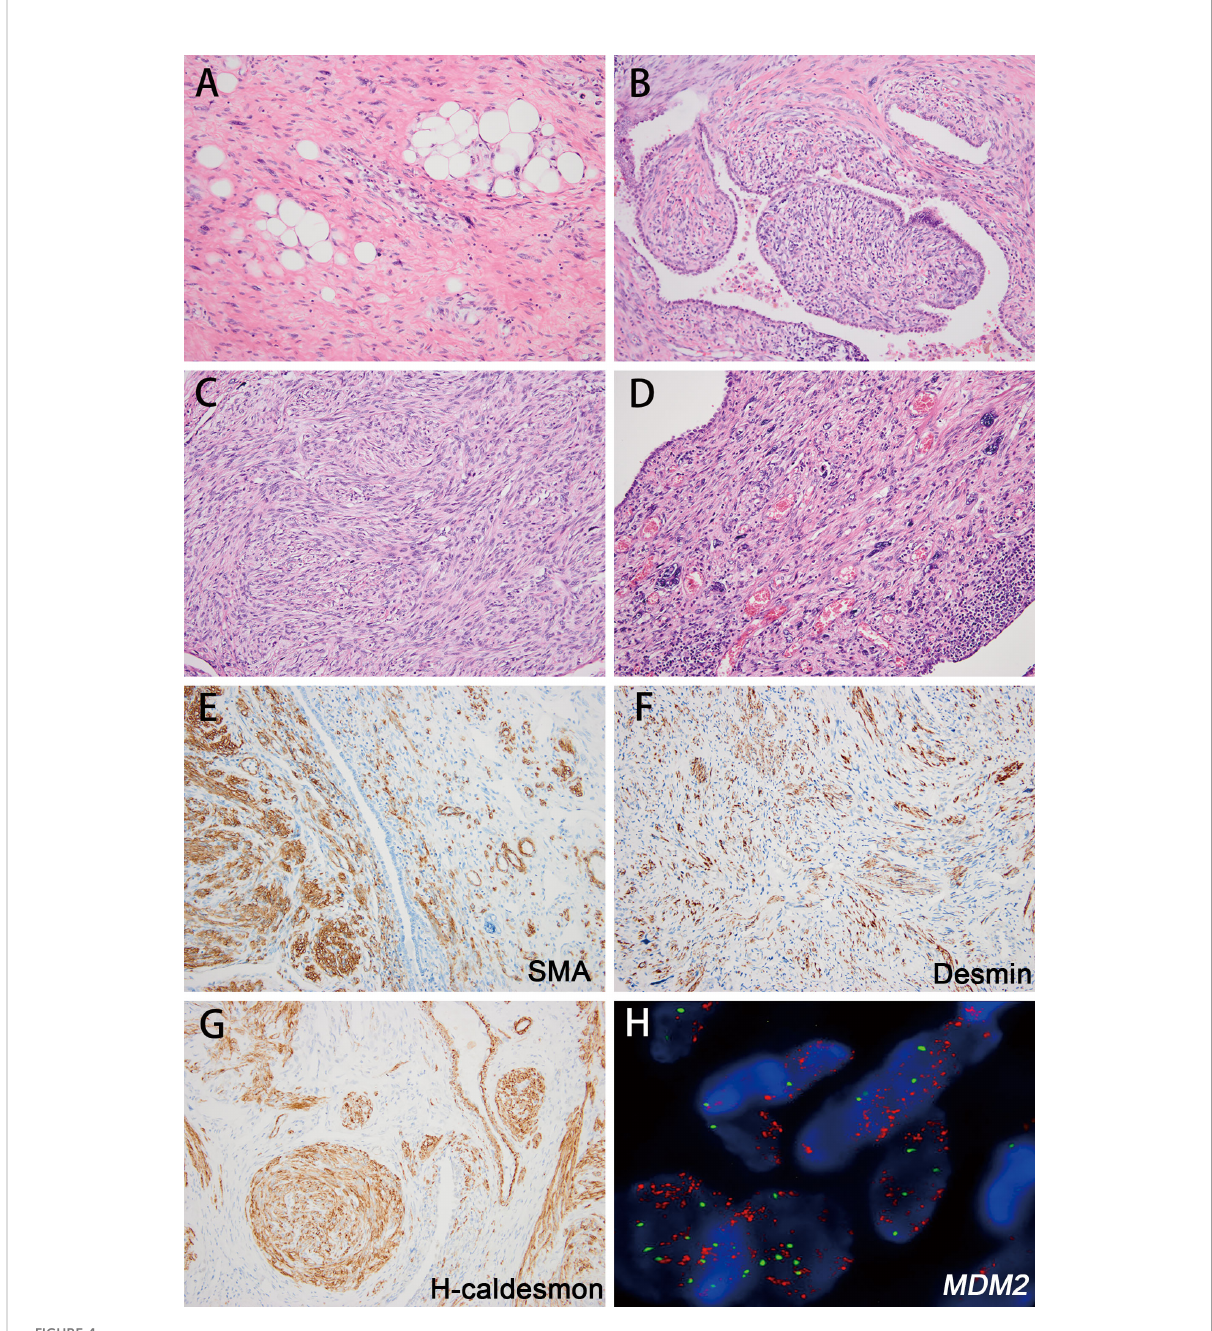
FIGURE 4 The histologic features of DDL with leiomyosarcomatous differentiation (case 33) and its corresponding immunohistochemical and fl uorescence in situ hybridization (FISH) image. Sclerotic well-differentiated area outside the lung ( A H&E; magni fi cation: 200×). At low magni fi cation, the growth of the spindle tumor cells showed cleft-like architecture, mimicking the pattern of pulmonary adeno fi broma ( B H&E; magni fi cation: 200×). Spindle tumor cells display a fascicular arrangement, with hyperchromatic, cigar-shaped nuclei and mild to moderate atypia ( C H&E; magni fi cation: 200×). The tumor cells exhibited increased nuclear atypia with obvious pleomorphism ( D H&E; magni fi cation: 200×). The tumor cells showed SMA ( E magni fi cation: 200×), desmin ( F magni fi cation: 200×) and h-caldesmon ( G magni fi cation: 200×) positivity in well- differentiated areas and negativity in focal sarcoma-like areas. MDM2 ampli fi cation was identi fi ed in this case (H)